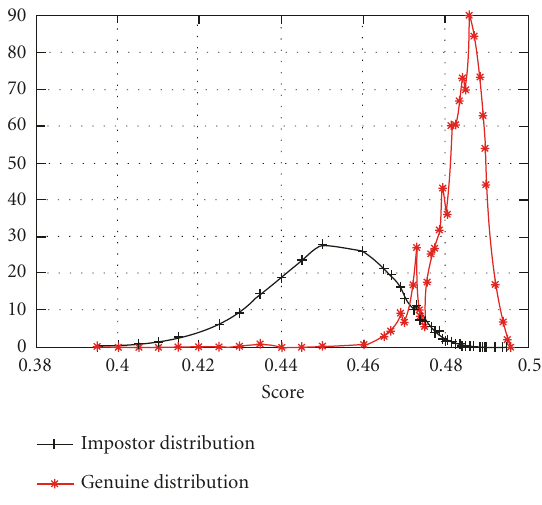
Figure 9: Density functions of impostor and genuine distributions for fusion of 3-feature extraction methods.